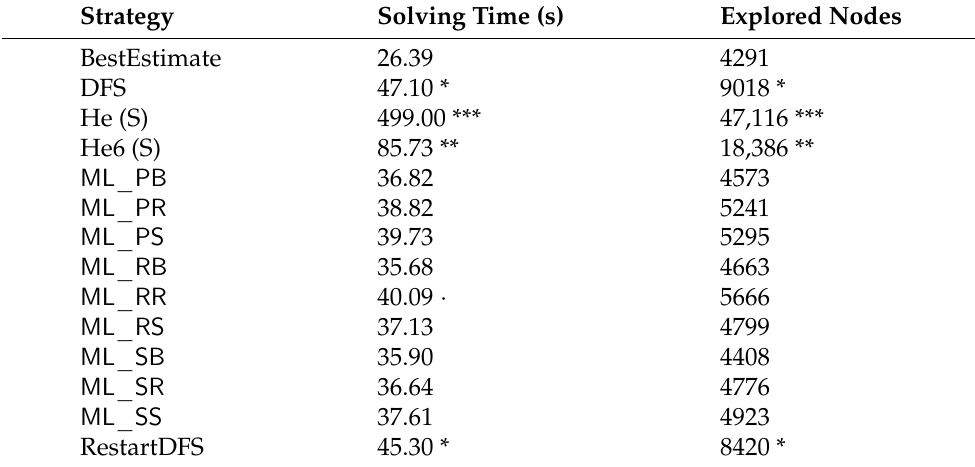
Table 6. Set cover instances: mean solving time and explored nodes for various node selection strategies. Pair-wise t -tests compared to BestEstimate : ‘***’ p < 0.001, ‘**’ p < 0.01, ‘*’ p < 0.05, ‘ · ’ p < 0.1.